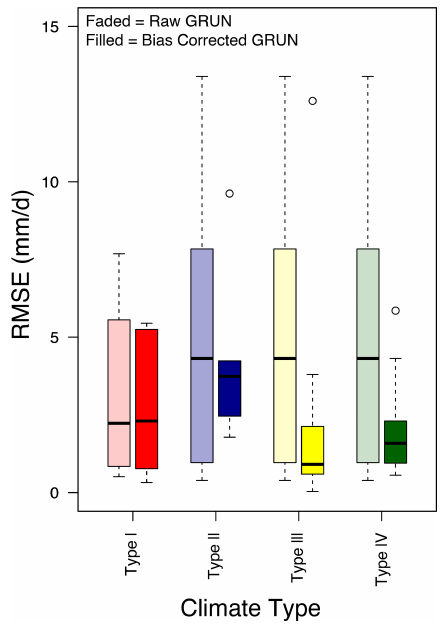
Figure 8. Box and whisker plots of the root mean square er- ror (RMSE) for catchments grouped by climate type of observed values versus raw GRUN values (light-colored boxes) and bias- corrected GRUN values (dark-colored boxes). For bias correction equation and country-wide results, see Table